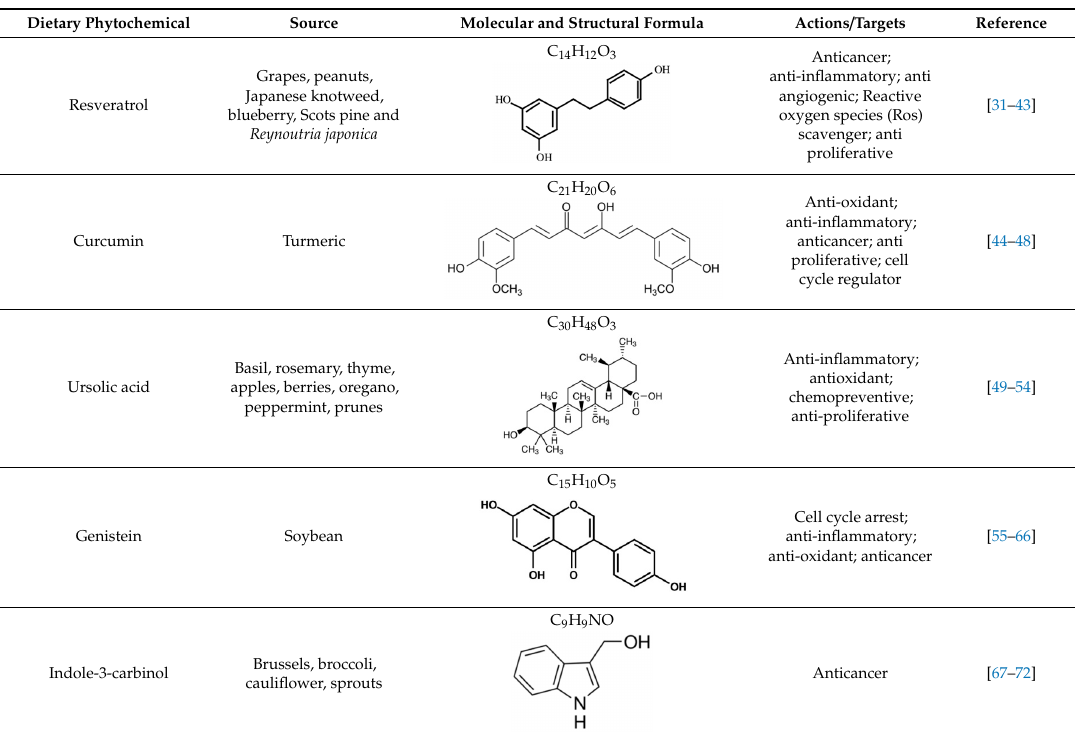
Table 1. Dietary phytochemicals and their proposed molecular mechanisms in the prevention of skin cancer. Dietary Phytochemical Source Molecular and Structural Formula